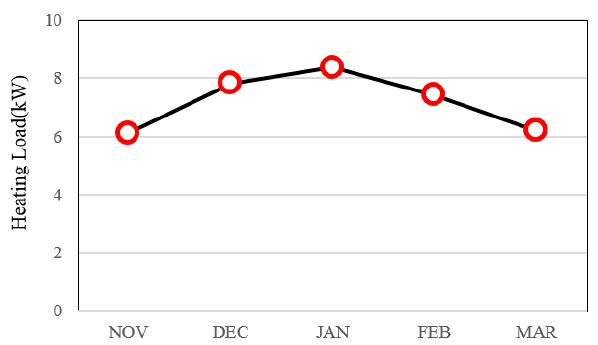
Figure 11. The peak load of heating season.